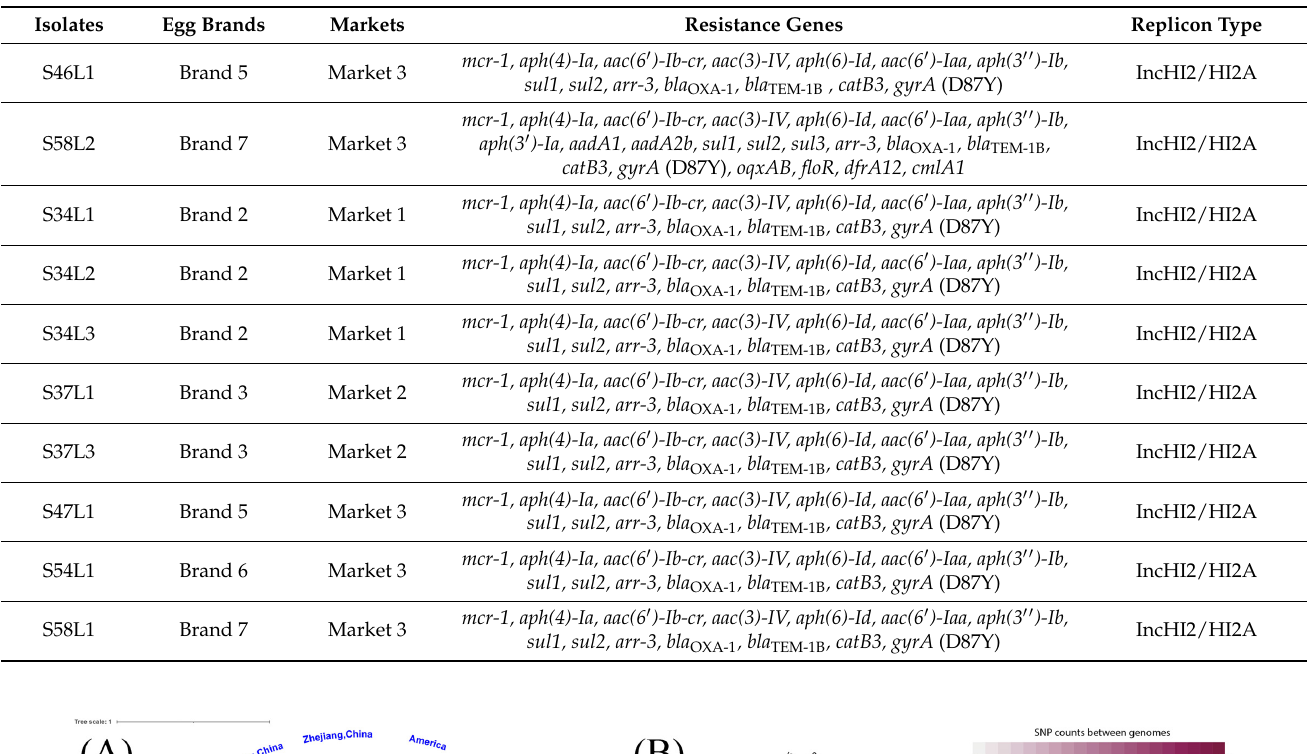
Table 4. Characteristics of the 10 mcr-1 -positive S . Typhimurium isolates derived from whole genome data analysis.